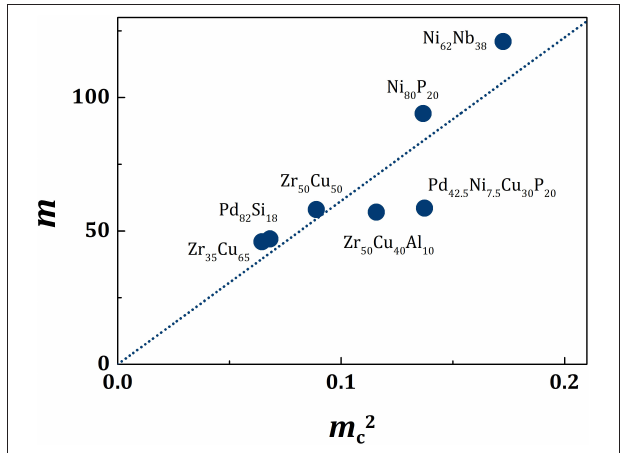
FIGURE 1 | The plot of m c 2 vs. m for various metallic liquids. The dotted line is for m 1 = 613 in Equation (13).